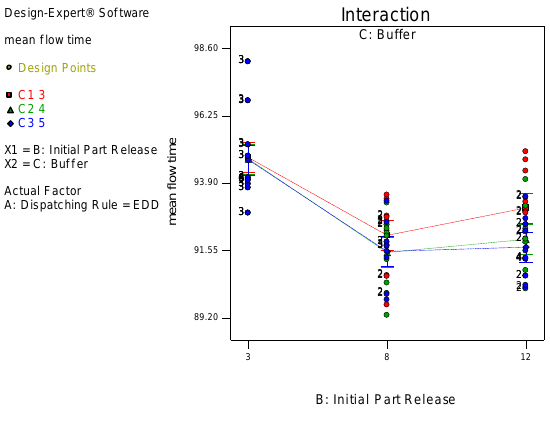
Figure 8. Average flow time, initial part release & buffer size for FIFO